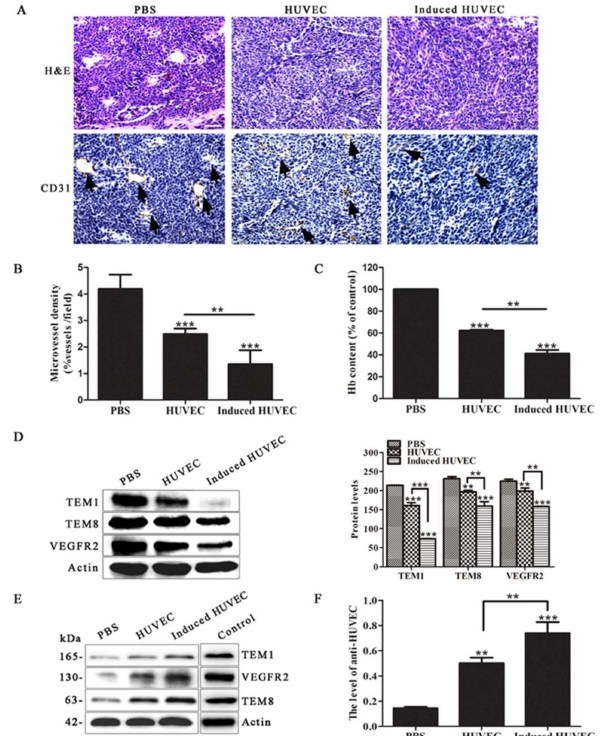
Figure 3. Induced HUVECs exerted better antiangiogenesis e ff ects than the HUVEC vaccine. ( A ) H&E staining and CD31-positive microvessels were tested by immunohistochemical staining (An arrow represented a CD31-positive microvessel); ( B ) vascular density was counted with CD31; ( C ) the hemoglobin level of the tumor tissues was examined by hemoglobin assay; ( D ) Western blot assay was performed to show the levels of the tumor endothelial cell markers TEM1, TEM8, and VEGFR2 in the tumor tissues; ( E ) a Western blot assay was performed to show the levels of anti-TEM1, anti-TEM8, and anti-VEGFR2 in mouse serum; ( F ) the level of the anti-induced HUVEC membrane protein antibody was checked by ELISA, (* p < 0.05; ** p < 0.01; *** p <